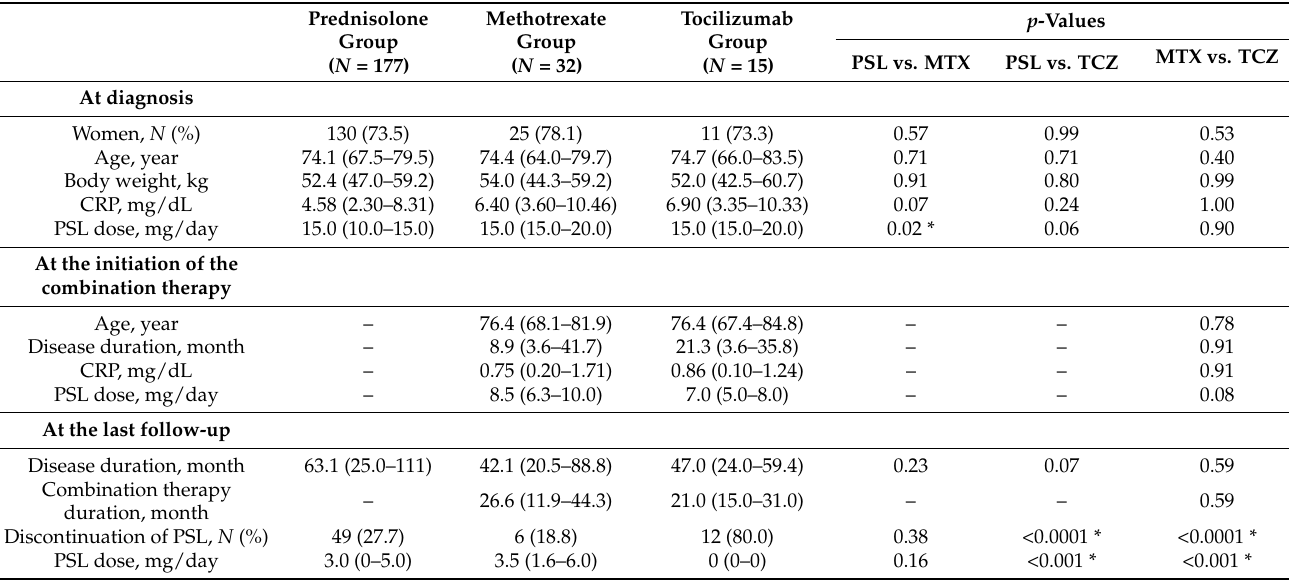
Table 1. Characteristics of the patients in the three groups.